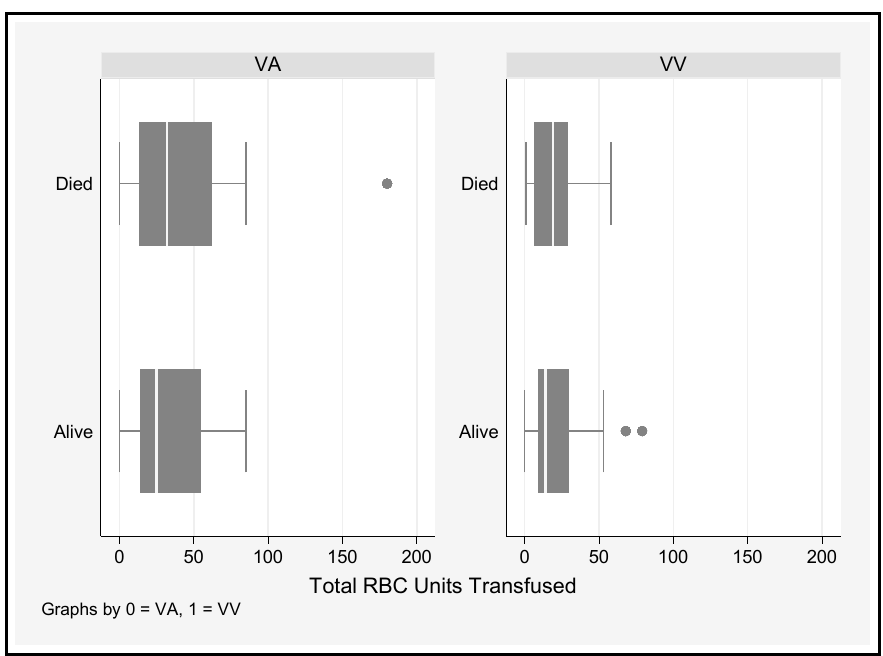
Figure 6. Comparison of total PRBC units tranfused between survivors and nonsurvivors who underwent VA and VV ECMO.